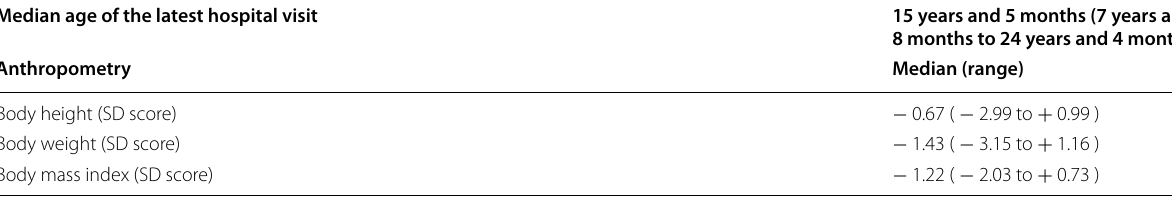
Table 2 Anthropometric values of the 14 surviving patients older than 6 years of age